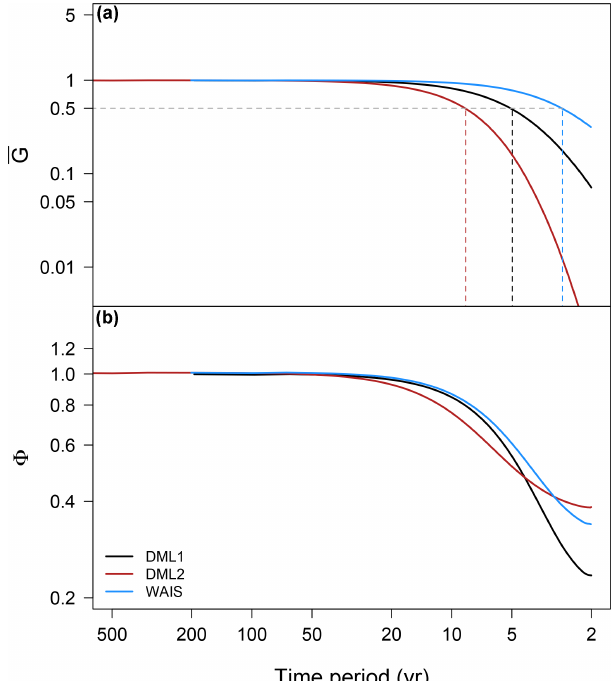
Figure B1. Estimates of the spectral transfer functions for the ef- fects of site-specific diffusion (a) and time uncertainty (b) for the three studied core arrays, DML1 (black), DML2 (red) and WAIS (blue). The estimates are based on simulations with surrogate data as explained in the text. Both effects are largely negligible beyond the decadal period. The horizontal dashed line in (a) at 0.5 denotes the transfer function value, which was chosen in order to constrain the diffusion correction (see main text). It corresponds to minimum time periods for the analysis of the respective spectral data that are indicated by the vertical dashed